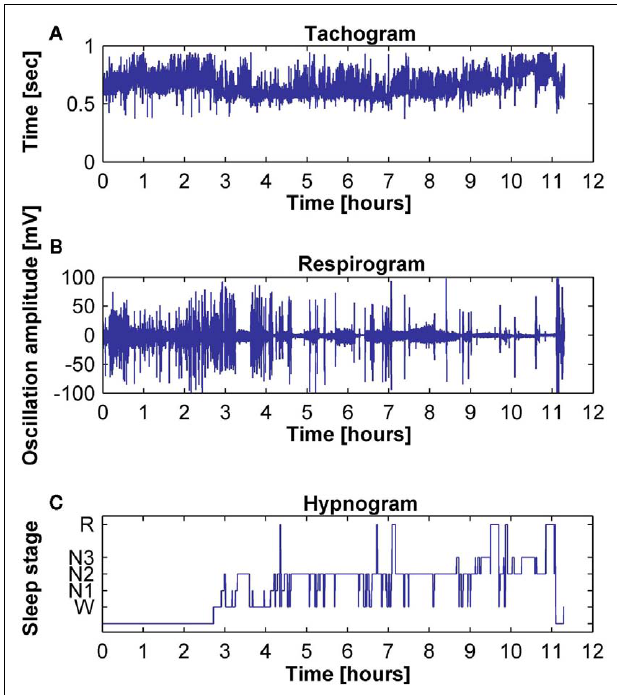
FIGURE 2 |Typical examples of (A) tachogram, (B) respirogram, and (C) hypnogram for a